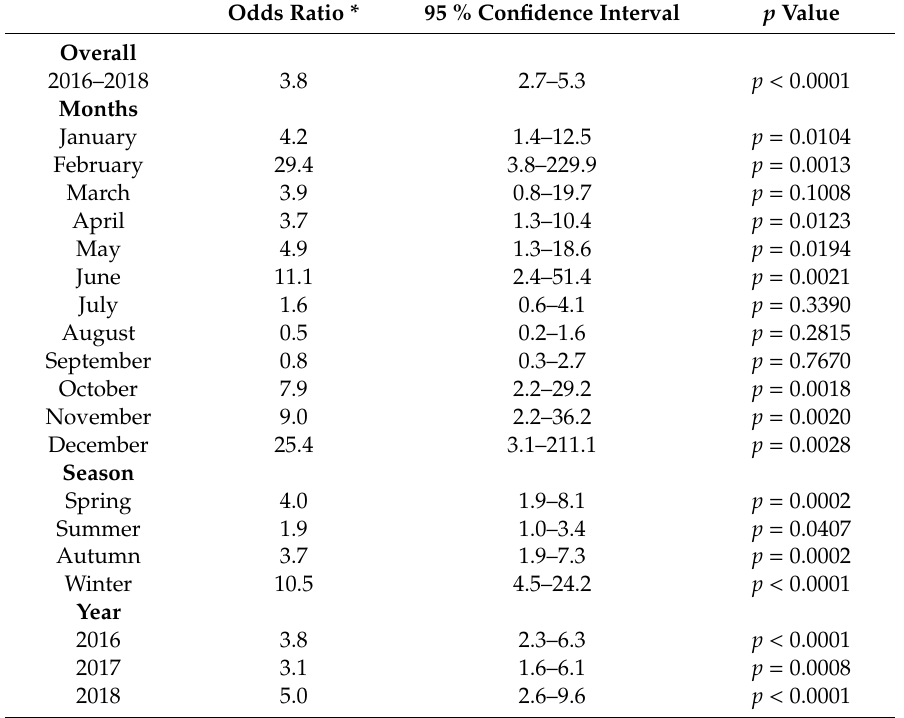
Table 3. Odds ratio analysis of the Salmonella prevalence in supermarkets over time. Odds Ratio * 95 % Confidence Interval p Value